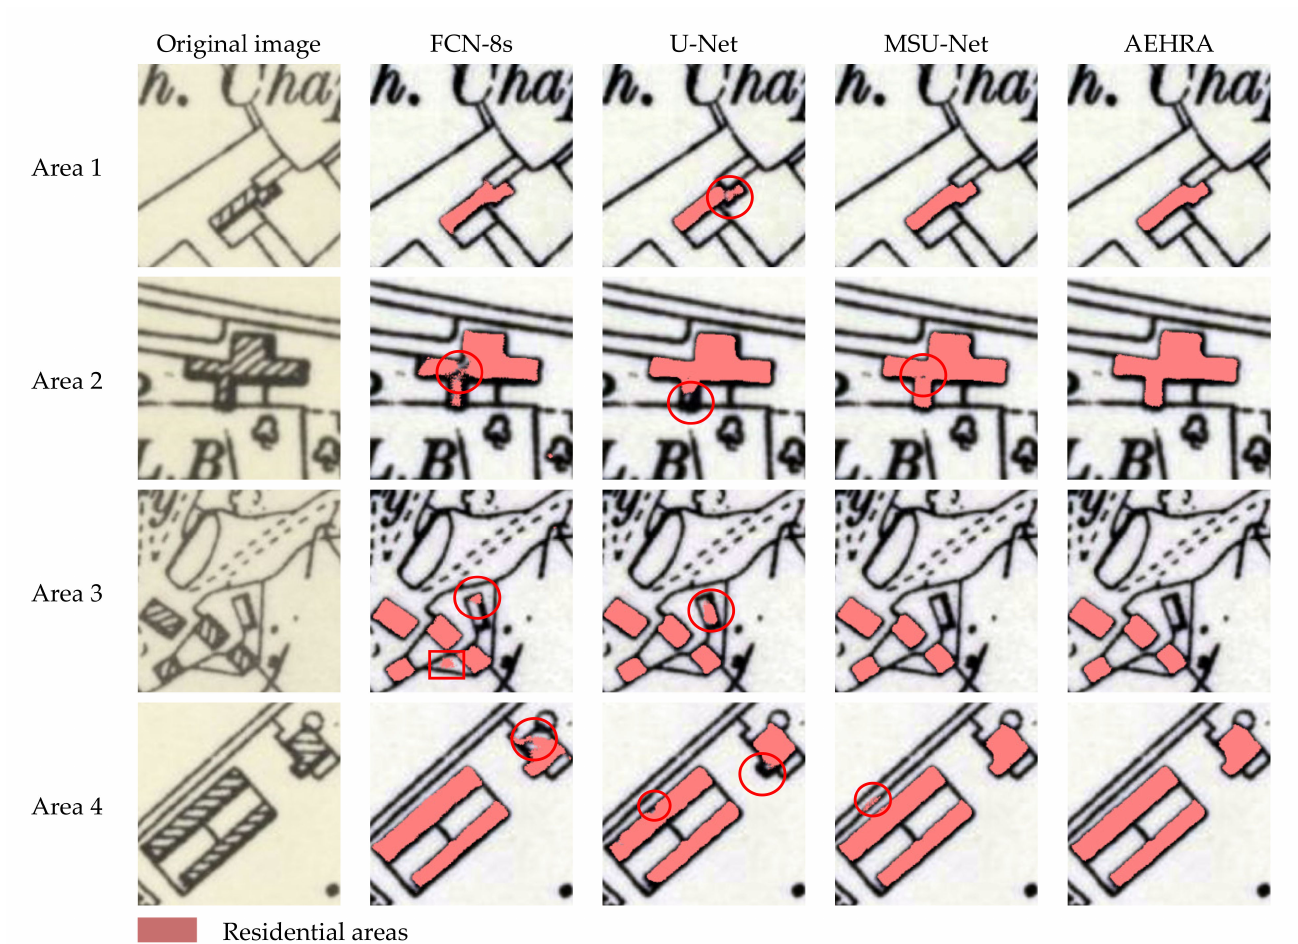
Figure 8. Segmentation results of hatched residential areas based on different algorithms.